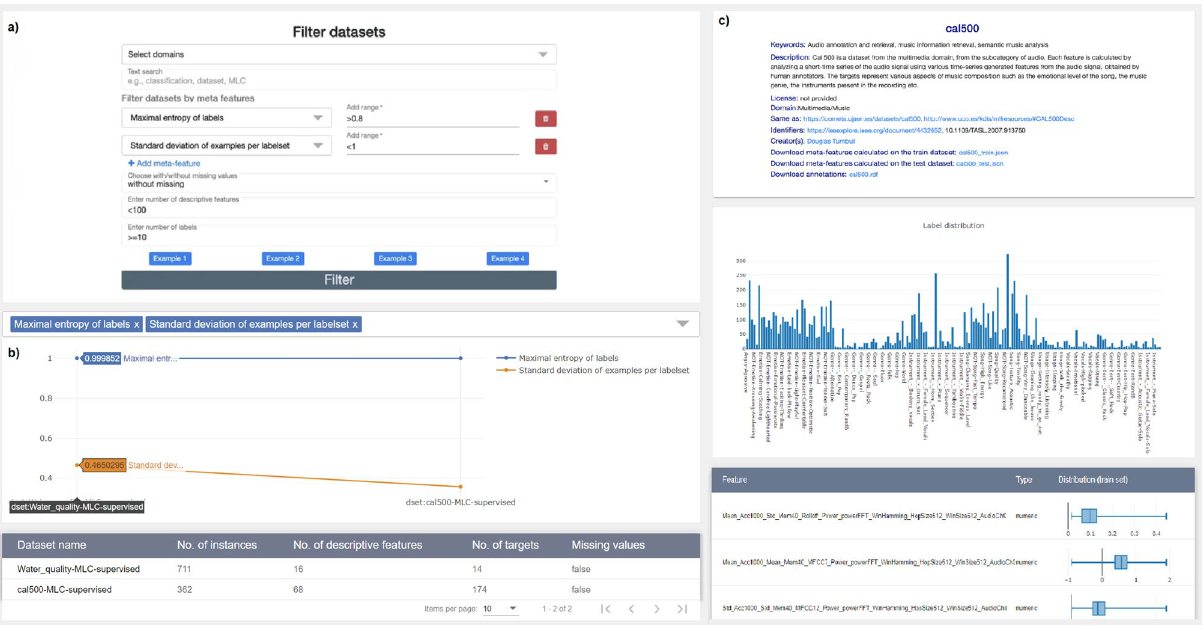
Figure 3. A screenshot of the multiple views developed within the GUI of the web-based system. ( a ) A filter for querying datasets according to a set of parameters. ( b ) Table with the results from the filter query and a scatter plot for visualizing the MLC meta-features. ( c ) A view of an individual dataset. It includes a panel for provenance information and links for downloading the raw dataset and the generated semantic annotations, a label frequency bar chart, and a table with the descriptive attributes present in the dataset and their distributions (box